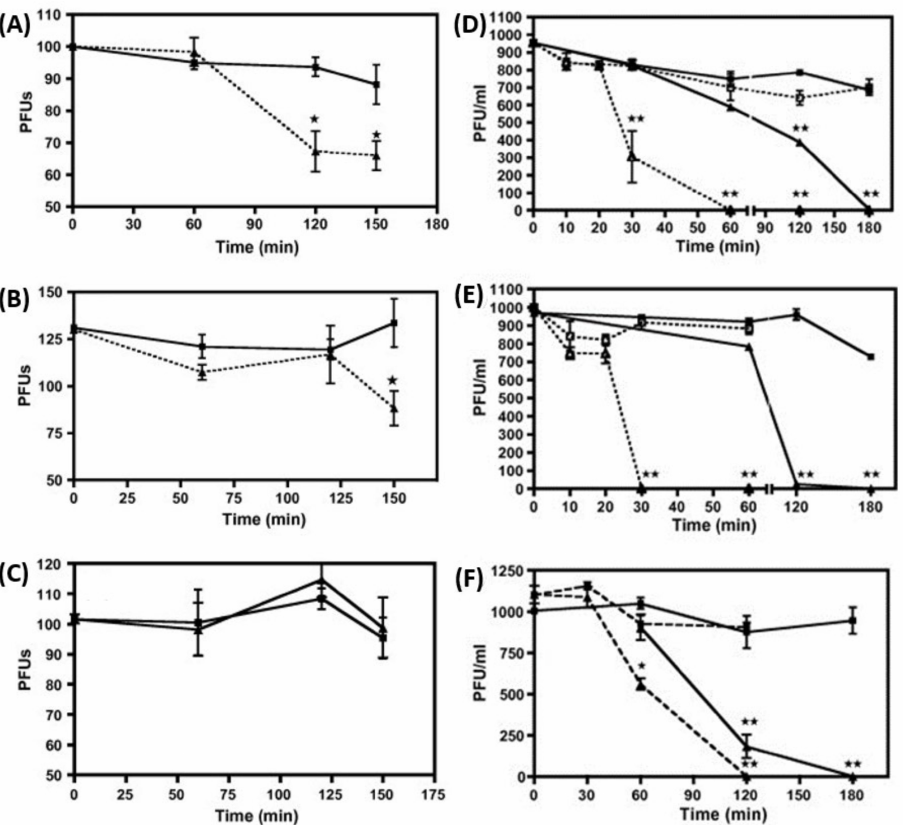
Figure 3. Inhibition effect of NO on influenza virus. ( A , D ) H1N1, ( B , E ) H3N2, ( C , F ) Influenza B. Left Graphics : Confluent cells were infected with the indicated virus at 100 PFU/well and then treated with 160 ppm NO for up to 2.5 h (triangles) or medical air as control (squares). Virus infectivity was assessed by plaque reduction assay. Right Graphics : Virions (1000 PFUs) suspended in normal saline were treated prior to infection with 80 or 160 ppm NO for 10–120 min (triangles) or medical air as control (squares). At the end of the treatment, the suspensions were used to infect a monolayer of confluent cells. Infectivity was assessed by plaque-reduction assay. * or ** p < 0.05. Reproduced with permission